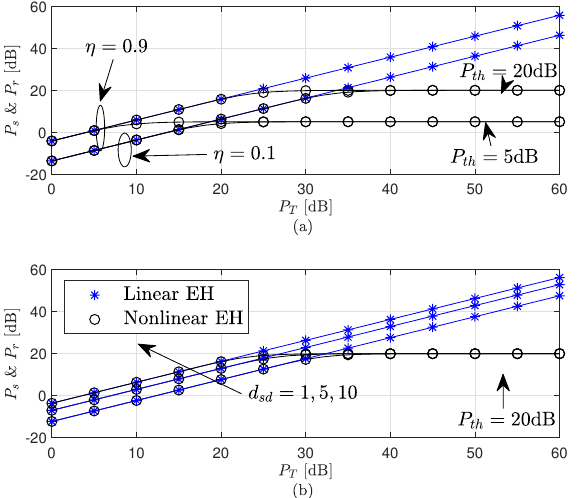
Figure 10. P s and P r of the WP DH AF relaying system ( a ) d sd = 2, ( b ) η = η s = η r =